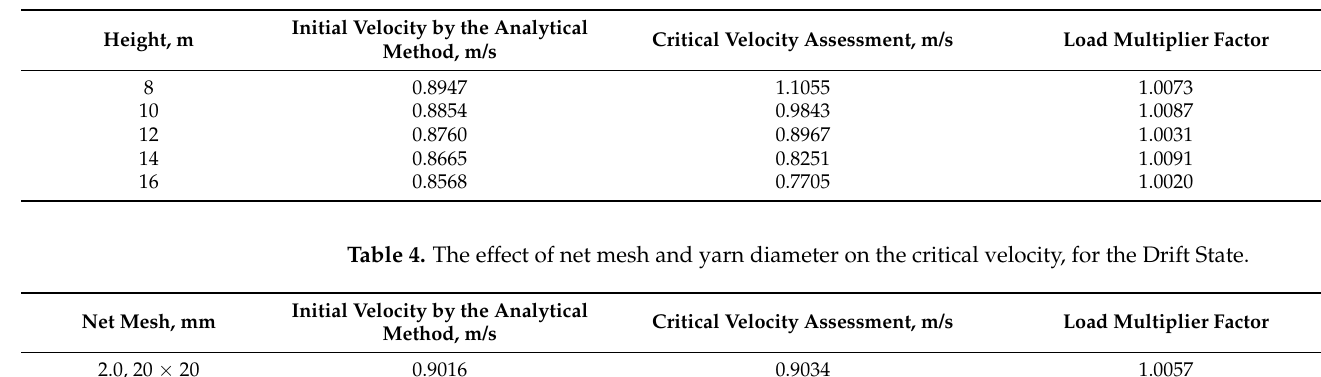
Table 3. The effect of cage height on the critical velocity, for the Drift State.